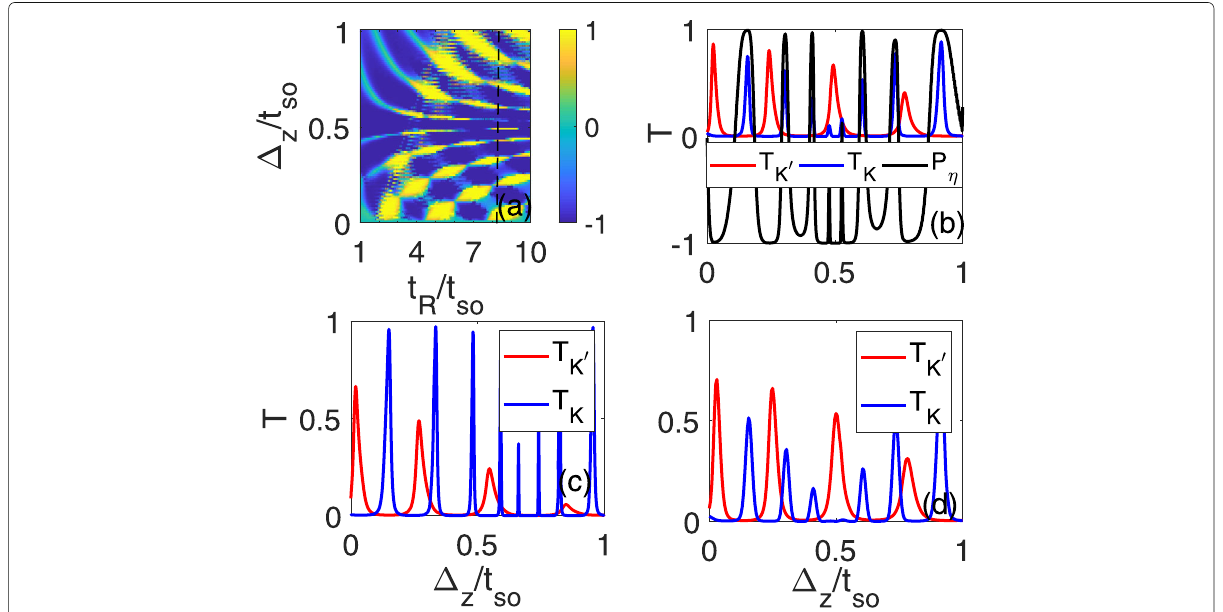
Fig. 4 Valley polarization a and T K / T K (cid:2) ( b – d ) as functions of (cid:10) z and t R . t R = 7.2 t so in ( b – d ), E f = 1.5 t so in c and d , and the on-site energy is E = 0.15 t in the left electrode in d ; all other parameters are identical to those in Fig.